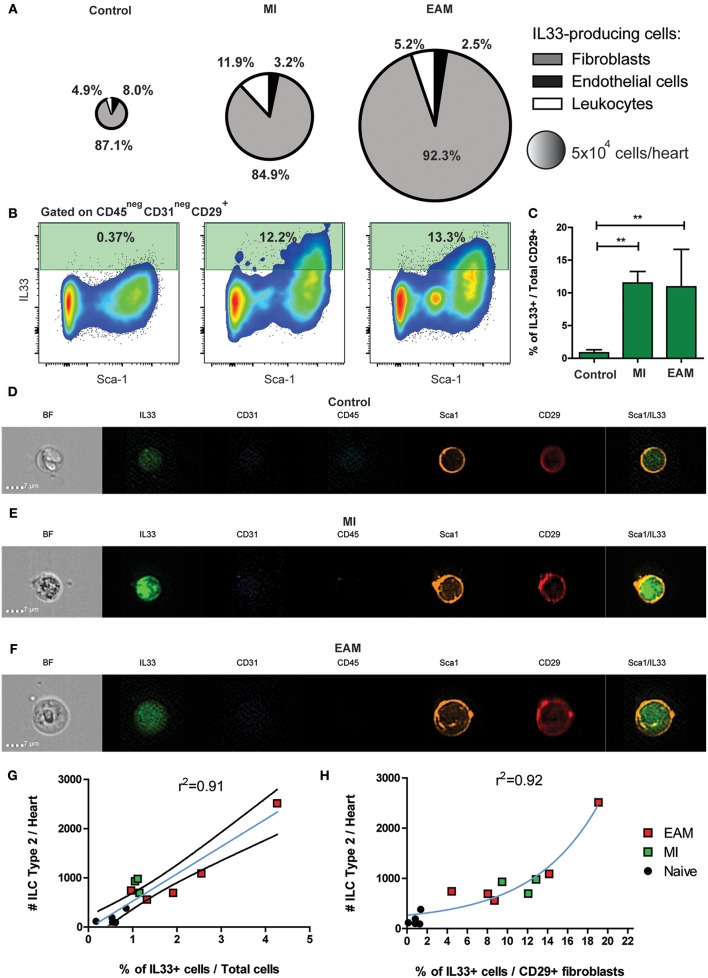
IL-33 is expressed by cardiac fibroblasts during MI and EAM. (A) Pie charts represent the percentage and total number of the heart IL-33-producing population and its composition in naïve, MI, and EAM hearts. Charts are based on concatenates of all mice in a group. (B) Representative flow plots of IL-33 expression by CD45negCD31negCD29+ fibroblasts are shown for all conditions. Median examples are shown. (C) Frequency of IL-33 producing cardiac fibroblasts in naïve, MI and EAM hearts. (D–F) Representative examples of Microscopy flow cytometry (ImageStream) single cells images, showing the pattern of IL-33, Sca-1, and CD29 expression in cardiac fibroblasts. Representative examples of 500–1,500 events per sample are shown. (G) Linear regression of absolute number of ILC2s and percentage of IL-33+ cells in naïve, MI, and EAM hearts analyzed together. Blue line shows linear function and black lines the 95% confidence interval. (H) Regression plot shows an exponential correlation between absolute number of ILC2s and percentage of IL-33+ cells amongst fibroblasts, represented by the blue line. Data of 1 of 2 independent experiments, n = 5 for controls and EAM, n = 3 for MI. Bar graphs shows Mean and SD. Correlations estimated using Pearson r. Statistic difference of means were calculated with Dunnett's test. **P < 0.01.